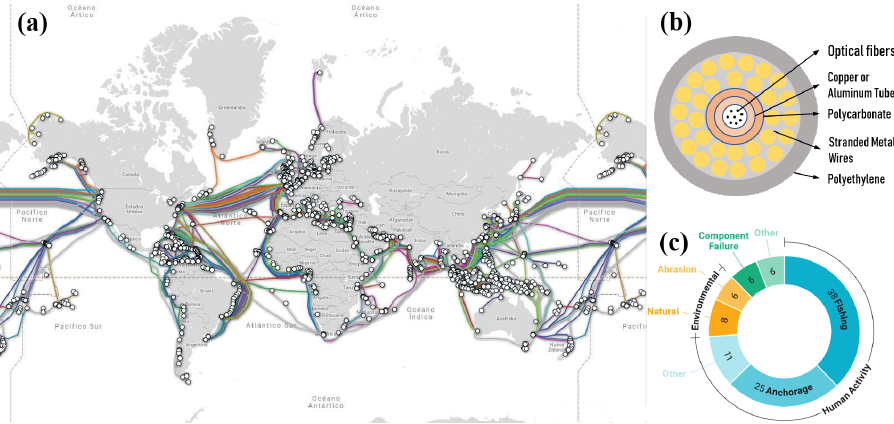
Figure 17. ( a ) Submarine cables around the world [152]. ( b ) Cross section of submarine communica- tion cable [153]. ( c ) Causes of faults for cables